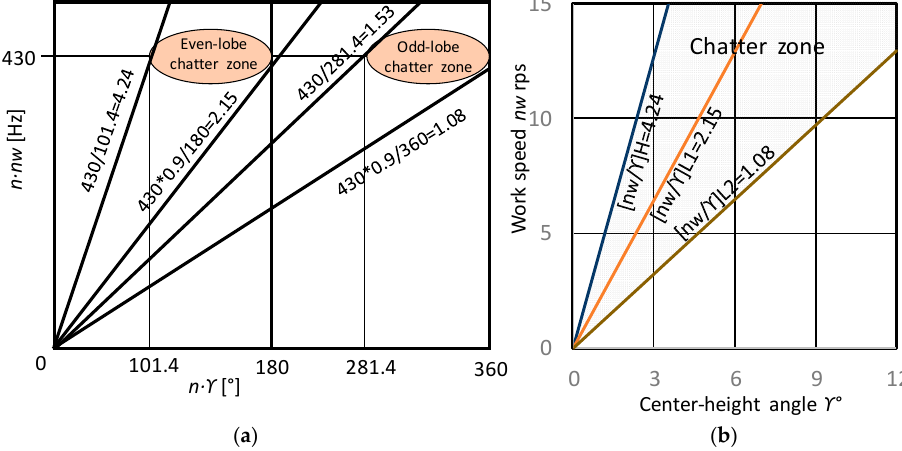
Figure 16. Dynamic system stability criterion for machine B. ( a ) Chatter zones on ( n· γ –n·n w ) diagram; ( b ) Chatter zones on ( γ –n w ) chart.